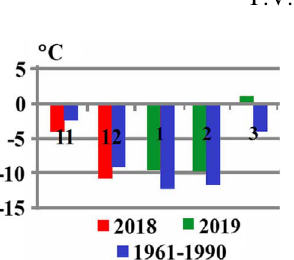
Figure 3. Comparison of average monthly temperatures of the low temperature season (November – March) at Almaty (Kazakhstan) in 2018 – 2019 and 1961 – 1990. Vertical coloured lines in the upper part denote mean maximum temperatures ( (cid:3) C) over the considered period and in the lower part, mean minimum temperatures ( (cid:3) C). The numbers indicate months: November (11), December (12), January (1), February (2), March